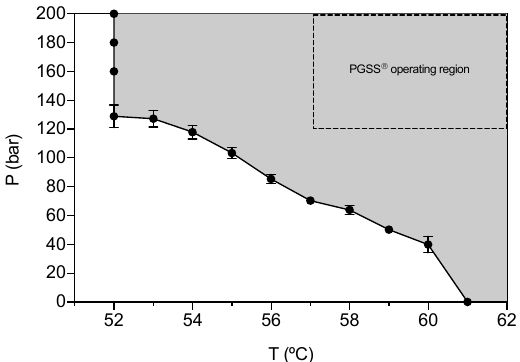
Figure 1. Glyceryl monostearate (GMS) melting points obtained at different pressures of CO 2 using a variable-volume high-pressure view cell. Grey area represents the pressure-temperature region at which GMS will be molten. The area delimited by the dashed line represents the operating region established for solid lipid microparticles (SLMPs) production by PGSS ® technique.